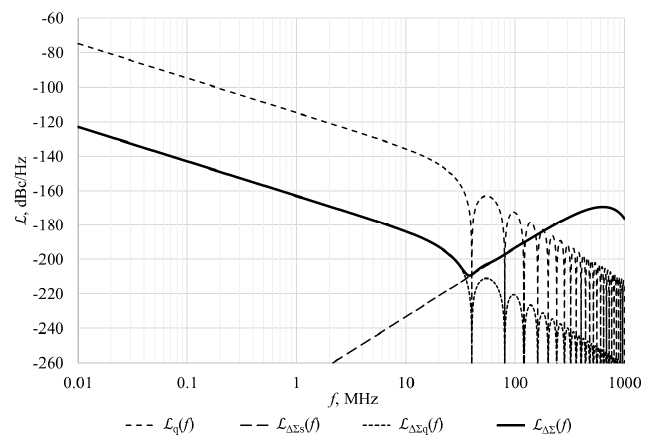
Figure 4. Calculated phase noise and its components, induced by quantization of digitally controlled oscillator, when f DCO = 6 GHz, f REF = 40 MHz, f ΔΣ = f DCO /4, Δ f RES = 40 kHz, W = 8, n = 3.